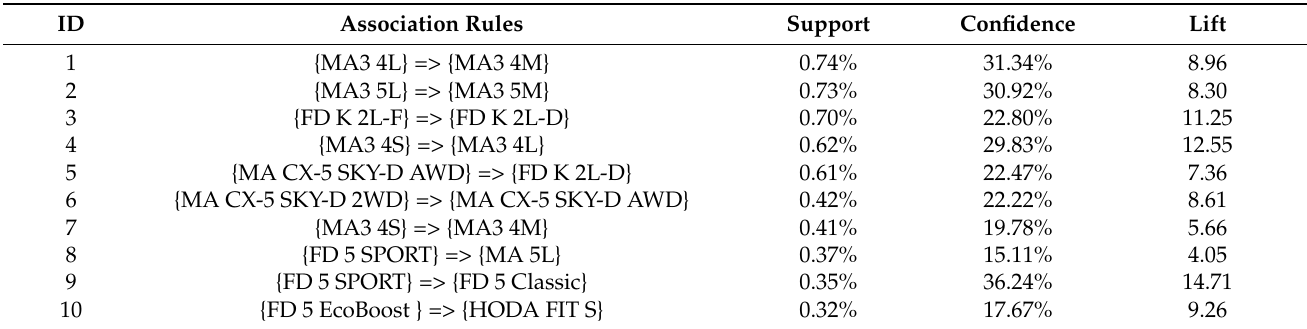
Table 2. Association rules illustration.